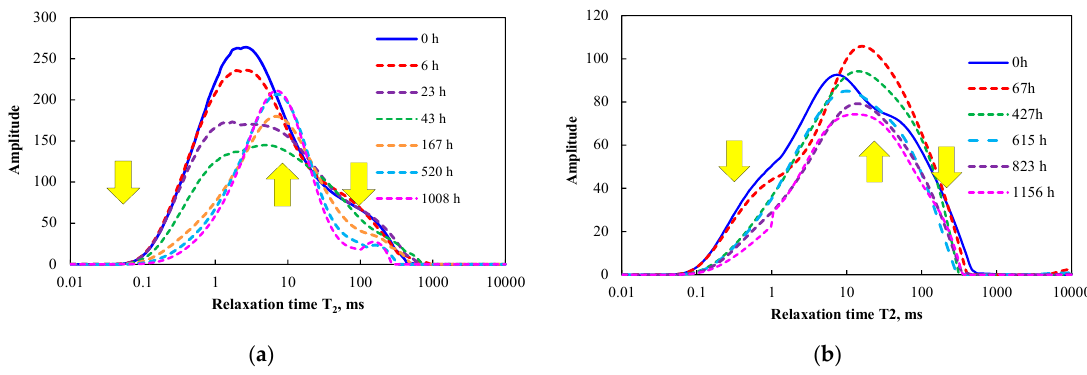
Figure 13. The T 2 spectra vs soaking time in QT-1 and QT-2 samples: ( a ) QT-1 and ( b ) QT-2.